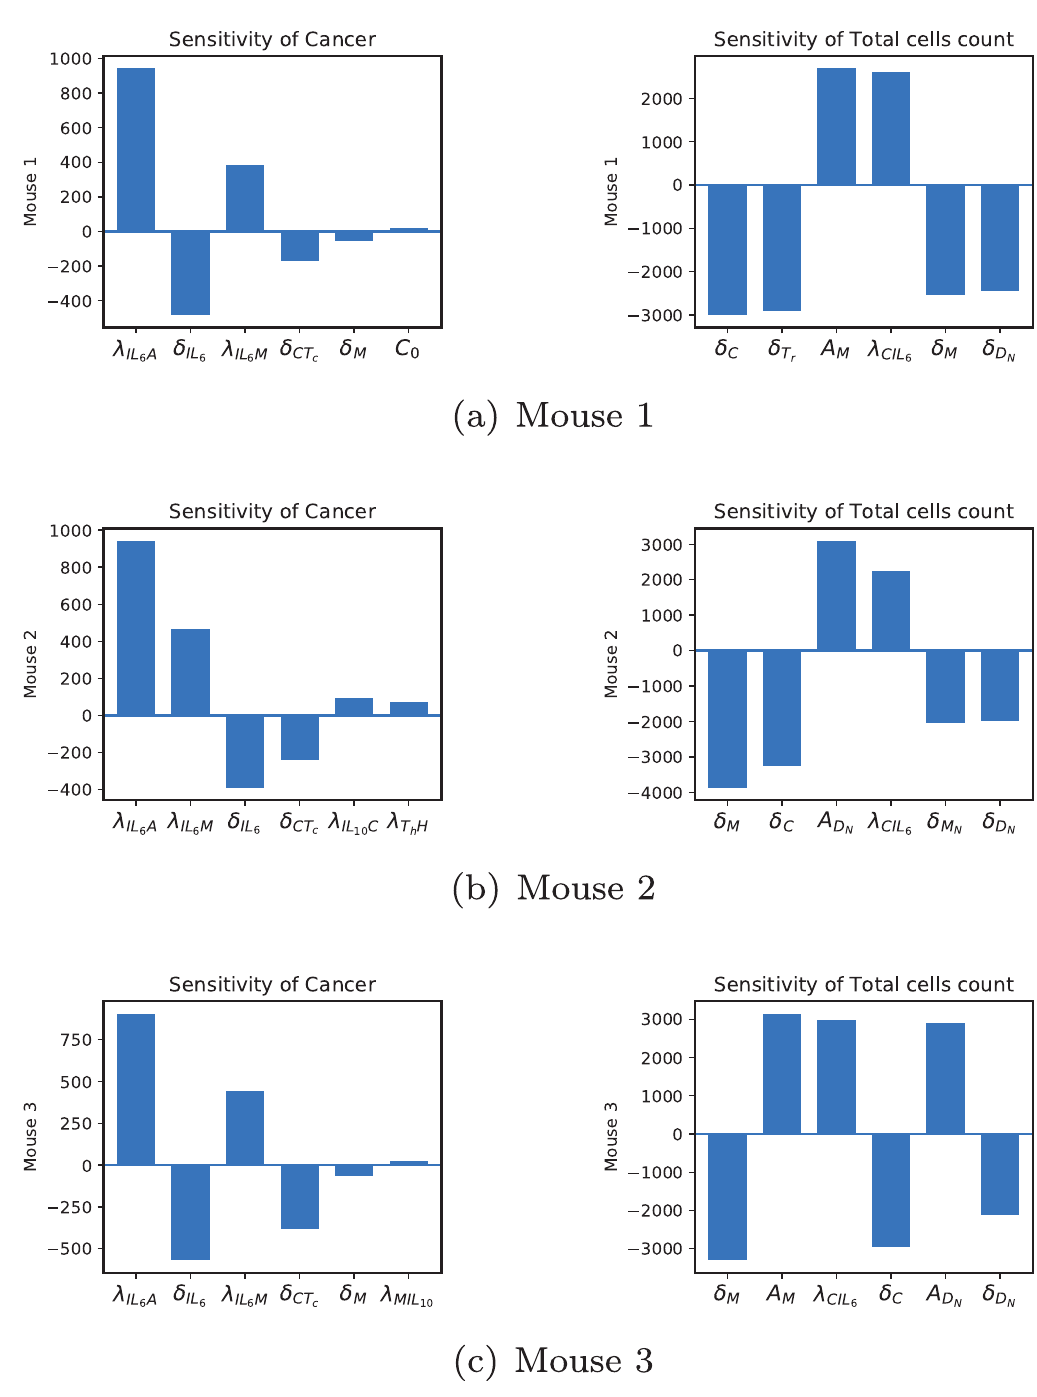
Fig 5. Sensitivity results. Other sensitive parameters for cancer and total number of